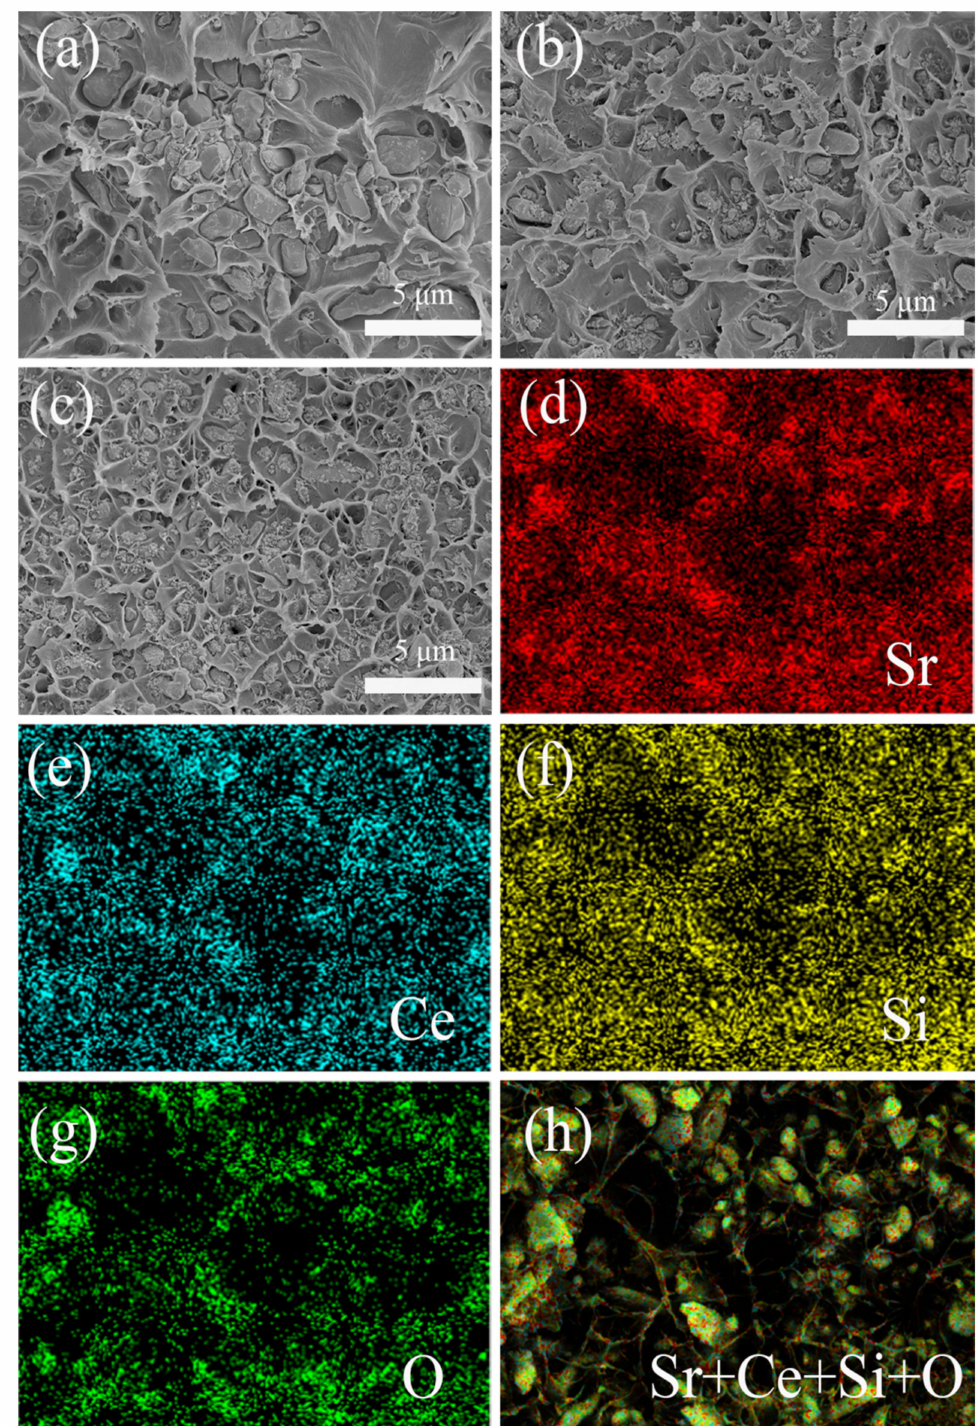
Figure 4. Cross-sectional SEM images of composites with different filler content: ( a ) COC/10 vol % Sr 2 CeO 4 ; ( b ) COC/10 vol % Sr 2 CeO 4 @SiO 2 ; ( c ) COC/20 vol % Sr 2 CeO 4 @SiO 2 ; ( d – h ) corresponding electron microscope images of COC/20 vol % Sr 2 CeO 4 @SiO 2